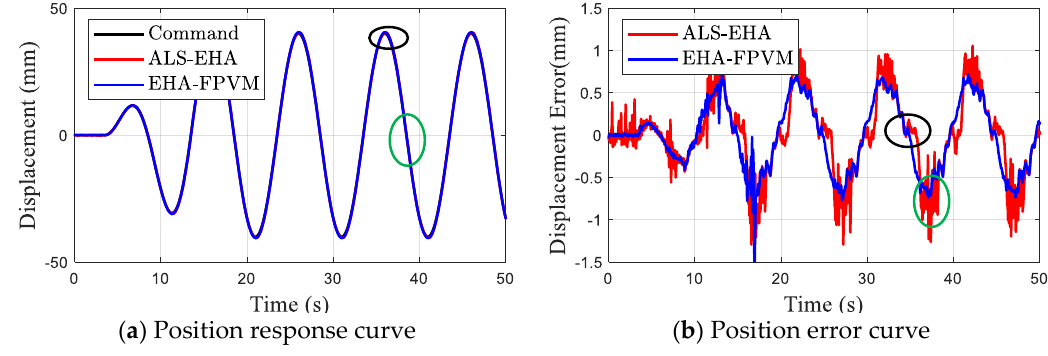
Figure 17. Position response and error curve.